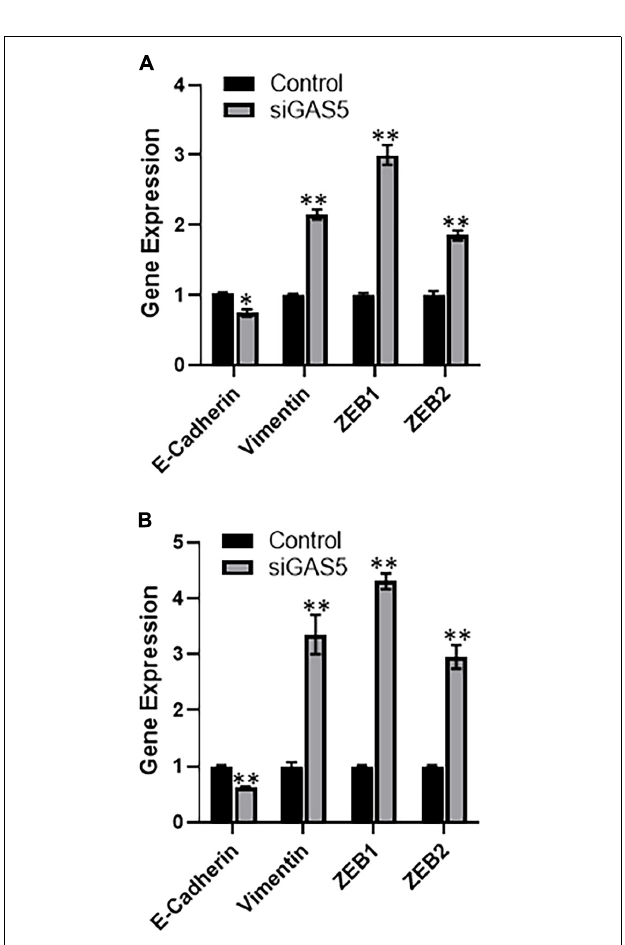
FIGURE 3 | Downregulation of growth arrest specific 5 (GAS5) induces epithelial–mesenchymal transition (EMT). GAS5 was downregulated by small-interfering RNA (siRNA) in panel (A) hFOB 1.19 and (B) U2OS cells, and the resulting effects on the expression of EMT genes, as indicated, were analyzed. Control cells (without GAS5 silencing) were assigned a value of “1,” and the corresponding differences in GAS5-silenced cells are shown. glyceraldehyde 3-phosphate dehydrogenase (GAPDH) was used as the internal control for analysis. * p < 0.05 and ** p <